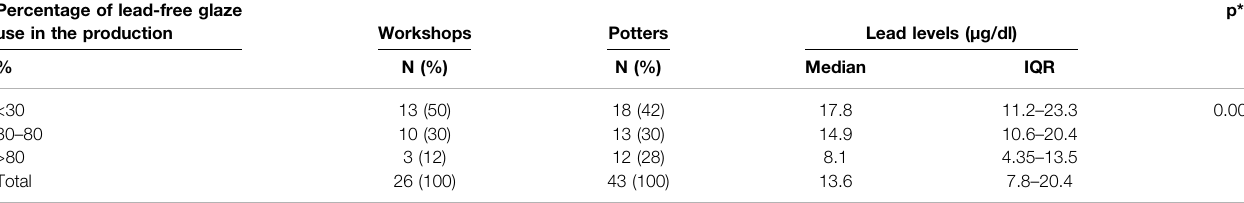
TABLE 2 | Levels of lead in capillary blood ( μ g/dl) by workshop and use of lead-free glaze. Percentage of lead-free glaze use in the production